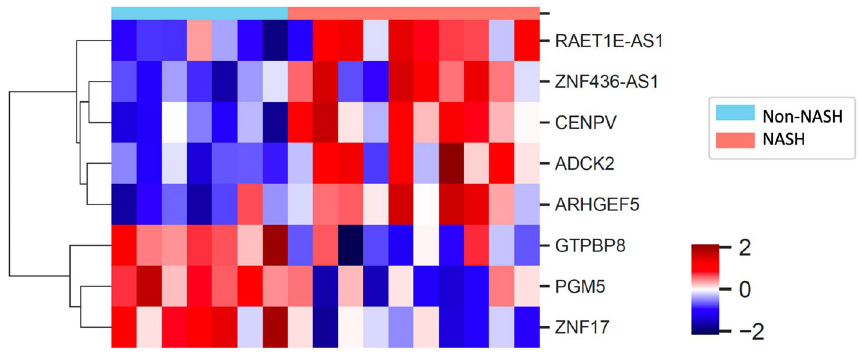
Figure 3. Heatmap showing expression of the 8 genes differently expressed in NASH compared to non-NASH based on Z